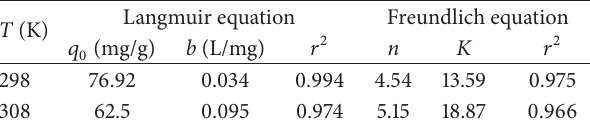
Figure 1: Langmuir adsorption isotherm of Ni(II) by the resin. Table 1: Isotherm constants for Ni 2+ adsorbed on D301R